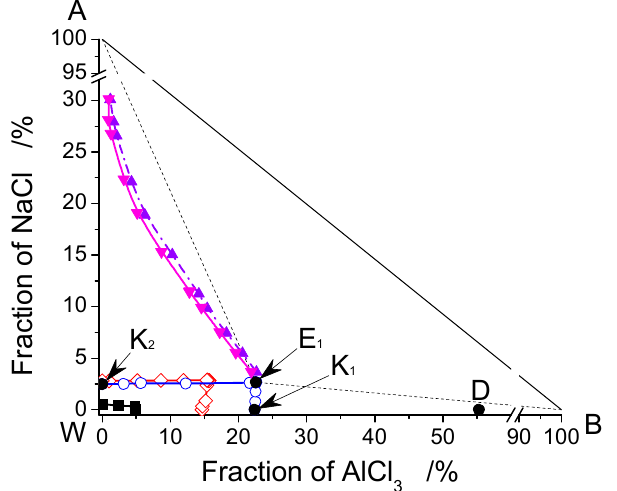
Figure 1. The phase diagram of AlCl 3 -NaCl-H 2 O system. A—NaCl, B—AlCl 3 , W—(HCl+H 2 O), D— AlCl 3 ·6H 2 O; ○ —H + = 1.3 mol/L at 353.15 K (this work), ◊ —H + = 4.0 mol/L at 353.15 K (this work);